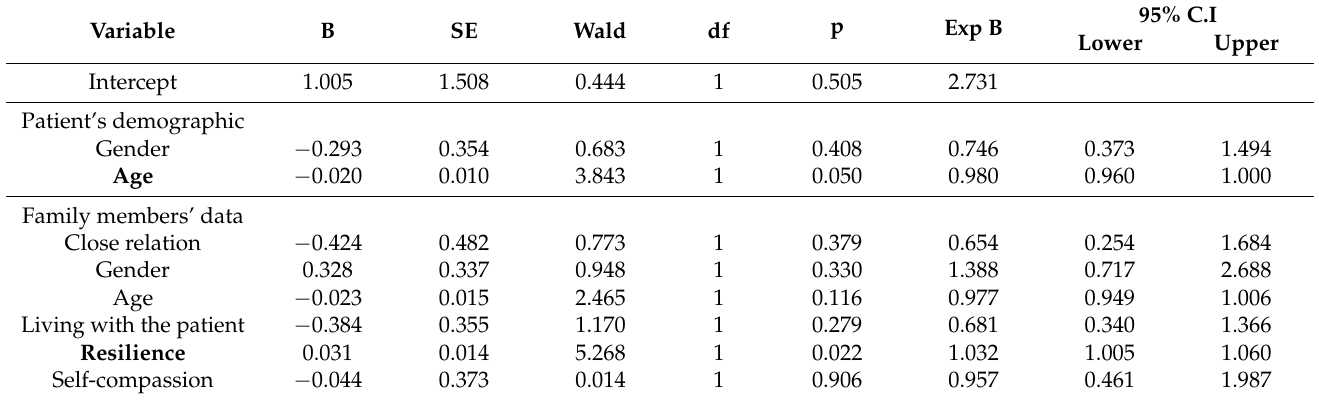
Table 5. Logistic prediction model of agreement between attendants’ and intensivists’ assessments.